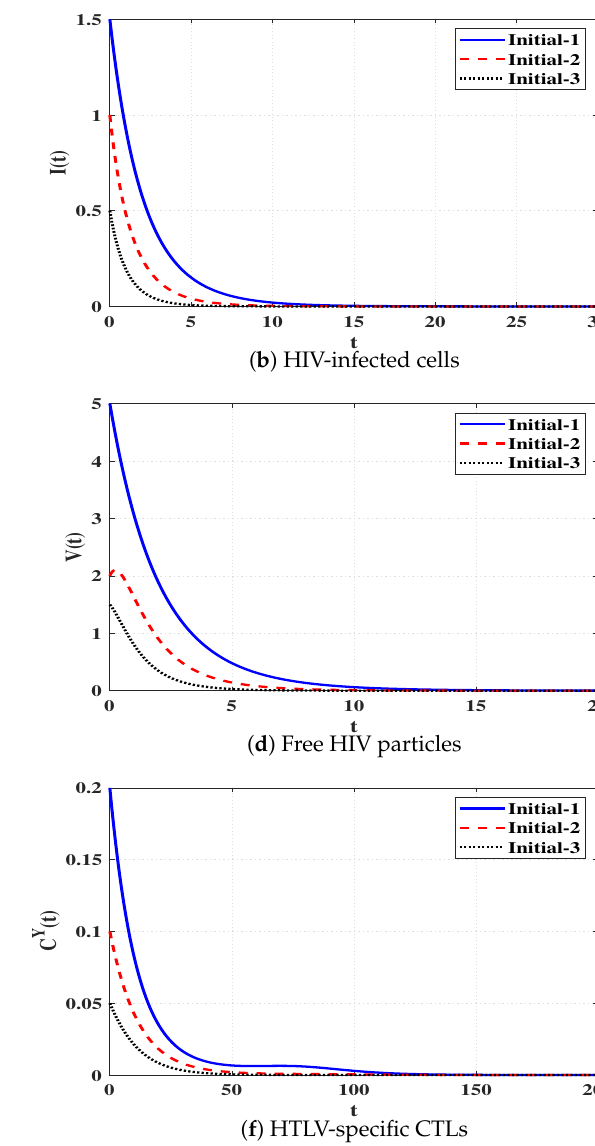
Figure 4. Solutions of system (4) when (cid:60) 2 > 1, (cid:60) 1 / (cid:60) 2 ≤ 1 and (cid:60) 4 ≤ 1. Set 6 (Stability of Ð 5 ) : η 1 = 0.001, η 2 = 0.0015, σ 1 = 0.15 and σ 2 = 0.033.